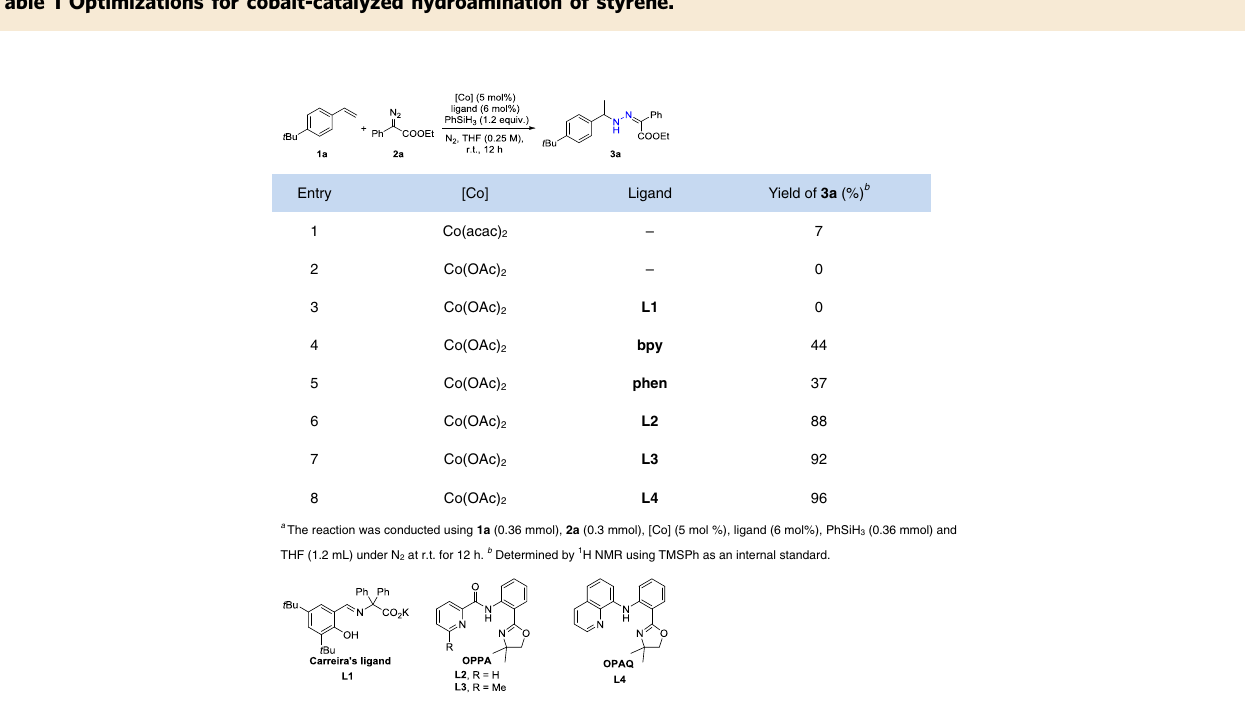
Table 1 Optimizations for cobalt-catalyzed hydroamination of